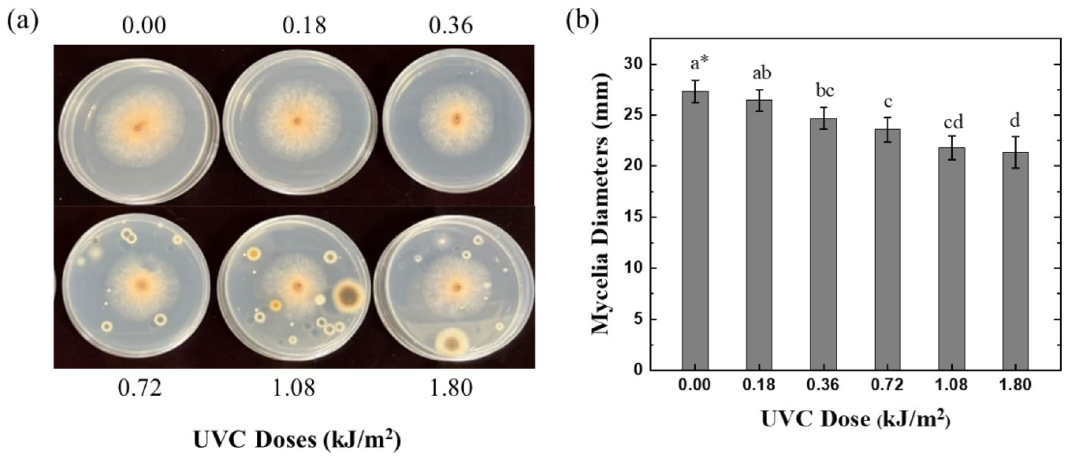
Figure 8. ( a ) The photos of fungi on PDA plates at different UVC doses and ( b ) the mycelial diameters of fungi at different UVC doses (* means within each column followed by the same letter are not significantly different at the 5.0% level according to